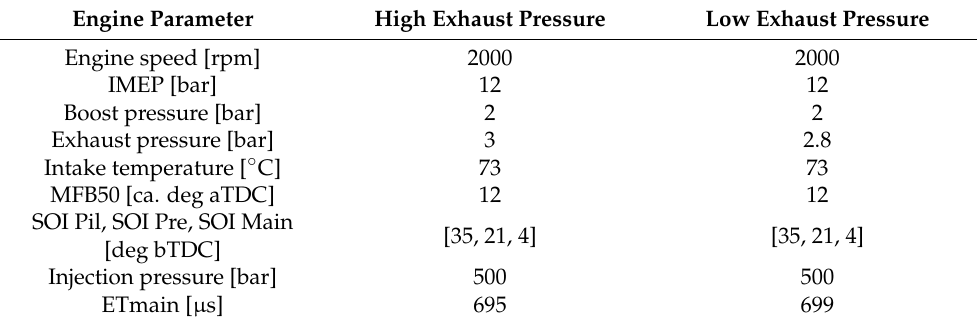
Table 4. Engine operating conditions testing the effect of two different amounts of residuals on